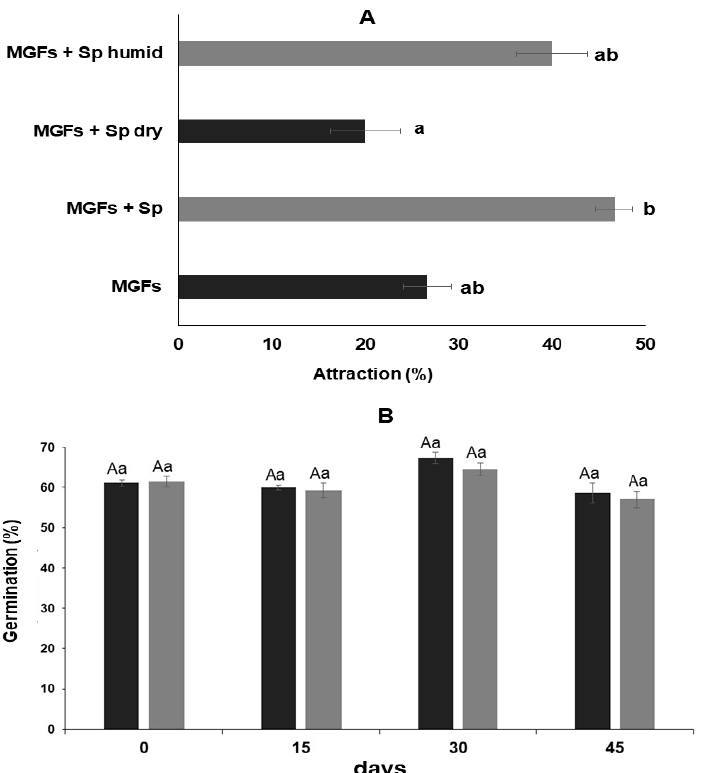
Figure 3. Ae. aegypti attraction by formulations. ( A ) Attraction percentage in Ae. aegypti adults of microgranular formulations plus Spirulina . Same letter on each column indicates that treatments were not significantly different (HSD Tukey test, p > 0.05). ( B ) B. bassiana conidia viability after different days of storage at different temperatures. Dark bars correspond to MGF + Spirulina at 25 °C ± 2 °C and gray bars represent MGF + Spirulina at 4 °C ± 2 °C storage temperature. Same letter on dark or gray column indicates not significantly different treatments (HSD Tukey test, p > 0.05). Data represent mean + SEM of triplicate determinations from three independent experiments. The same letter between columns in the same storage time indicates not significantly different treatments (Student t test; p ˂ 0.05). Treatments were MGF + Spirulina at 25 °C ± 2 °C and 4 °C ± 1 °C.